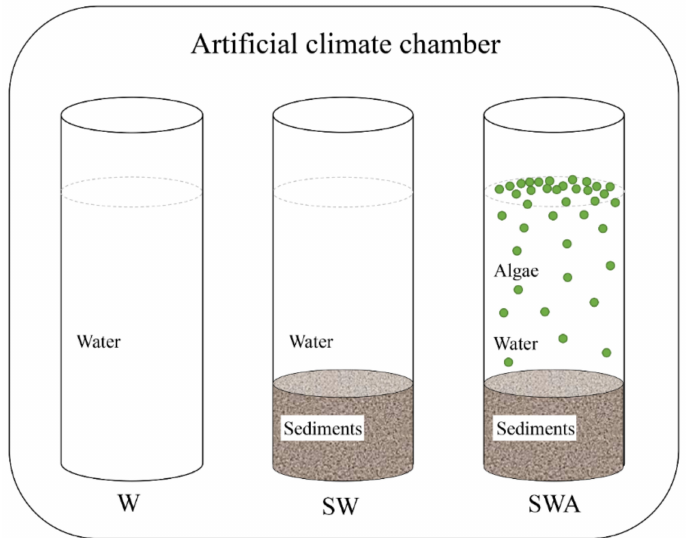
Figure 1. Schematic diagram of the indoor simulated black blooms setup. (artificial climate chamber: temperature of 25–30 ◦ C, day-night cycle of 16 h:8 h, sunshine intensity of 8000 lx. W: water, SW: sediments-water, SWA: